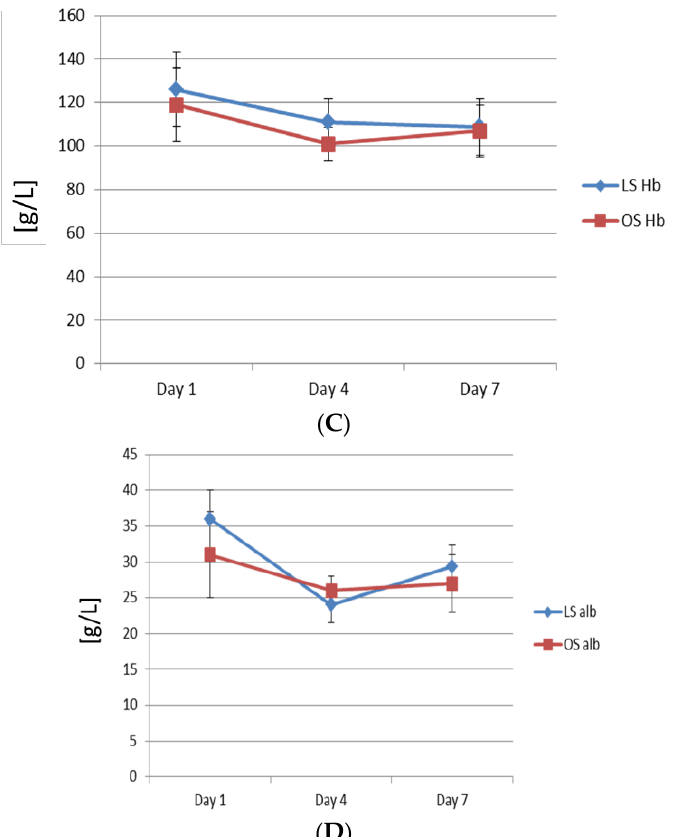
Figure 1. Postoperative dynamics of serum leptin, CRP, haemoglobin, and albumin between groups. ( A ) Postoperative dynamics of serum leptin concentrations. ( B ) Postoperative dynamics of serum CRP. ( C ) Postoperative dynamics of serum haemoglobin. ( D ) Postoperative dynamics of serum albumin. LS: laparoscopic surgery; OS: open